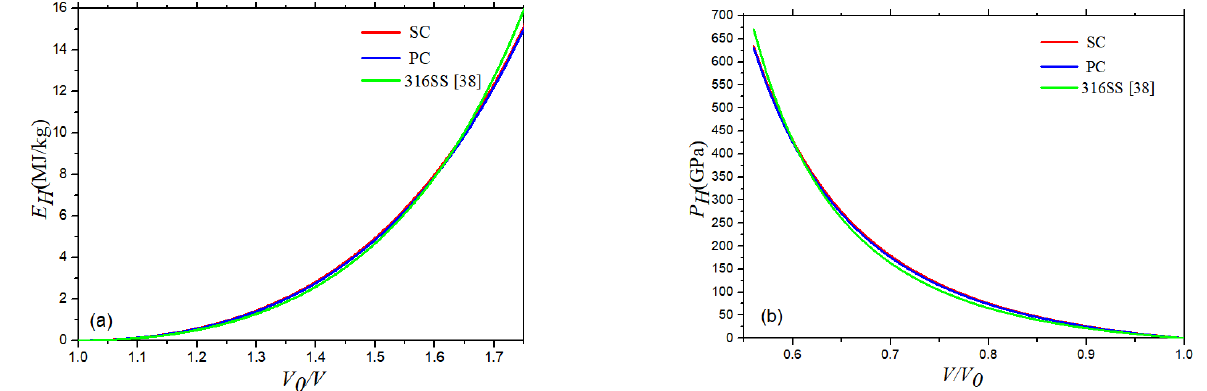
Figure 4. Hugoniot curves: ( a ) E H ( V ) curve and ( b ) P H ( V ) curve of 316 stainless steel at 300 K.